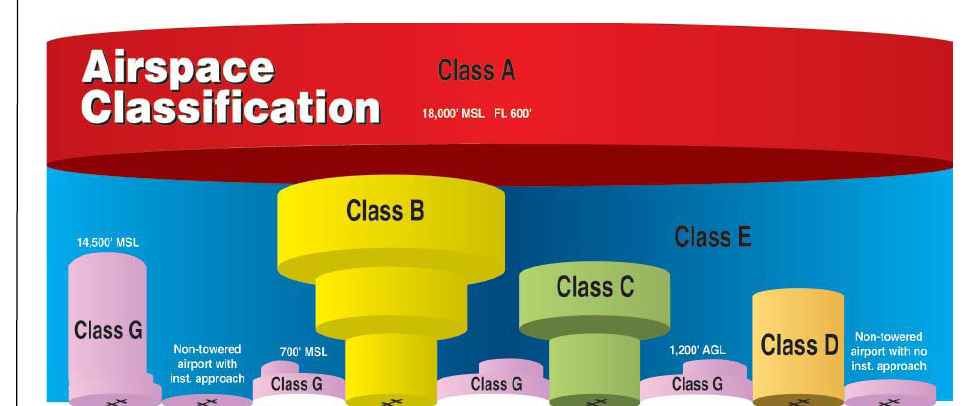
Figure 1 – Distribution of airspace by classes (Federal Aviation Administration, 2018) Рис . 1 – Классификация воздушного пространства (Federal Aviation Administration, 2018) Слика 1 – Подела ваздушног простора по класама (Federal Aviation Administration, 2018)